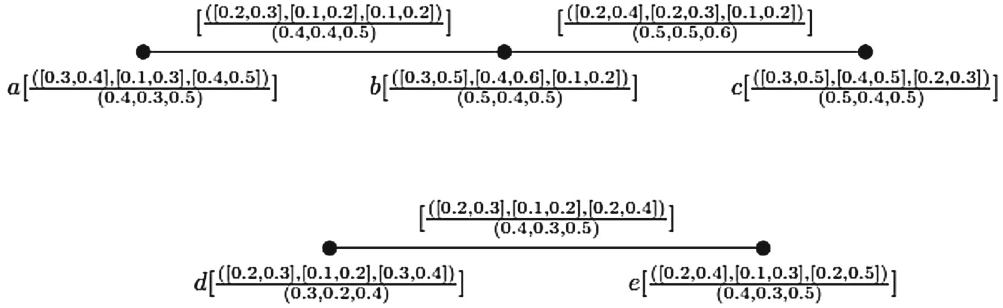
Figure 5: 3pc graphs G